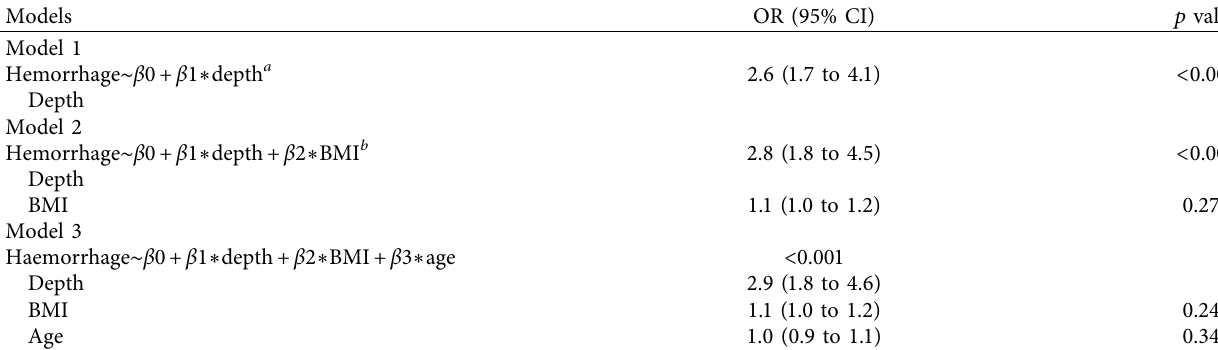
Table 2: Prediction model of haemorrhage volume by depth, BMI, and age.